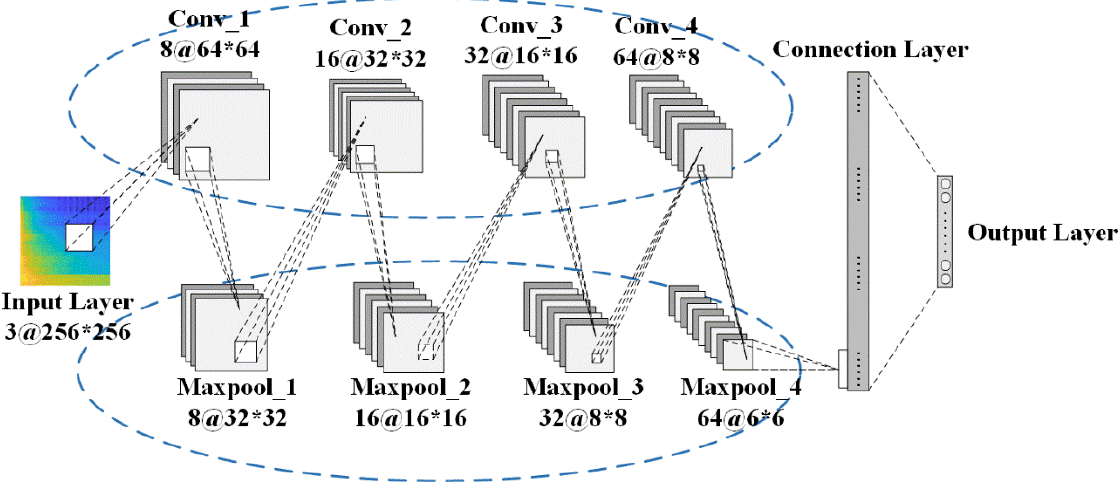
Figure 2. The CNN model.